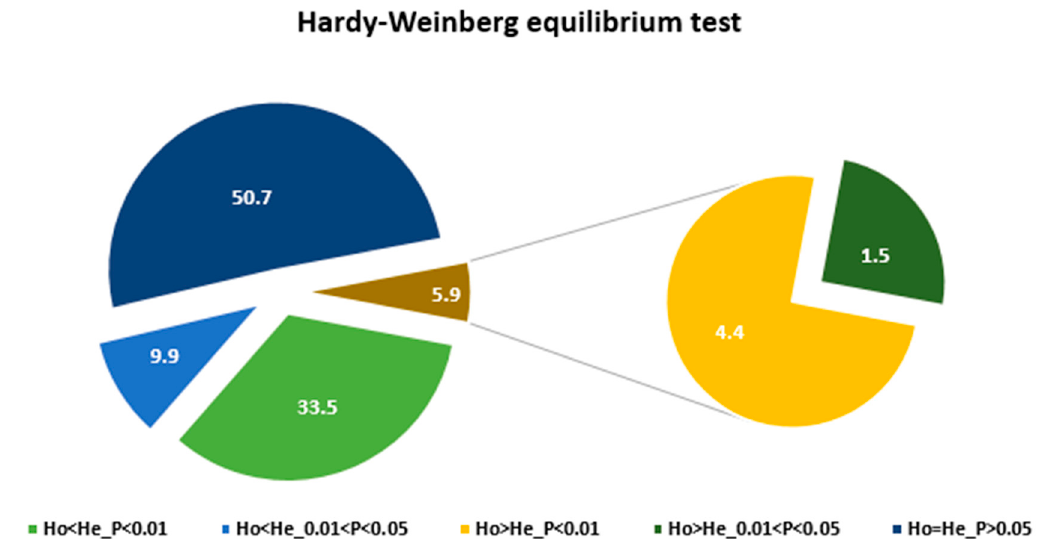
Figure 2. Pie-chart of the SNP loci significantly deviated from Hardy-Weinberg equilibrium (HWE) showing their proportions in terms of heterozygote excess and deficiency at different levels of significance .